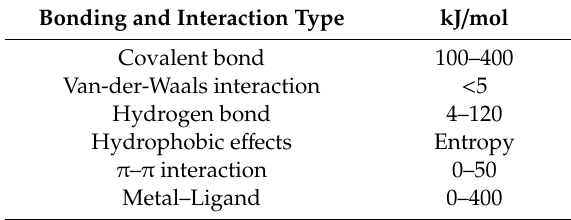
Table 1. Strength of the main interactions involved in nanomaterials